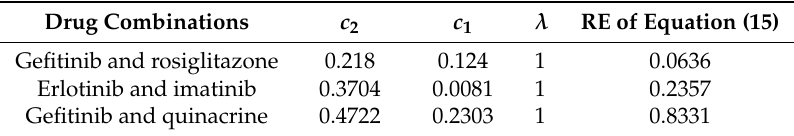
Table 3. The parameters value obtained by PSO.